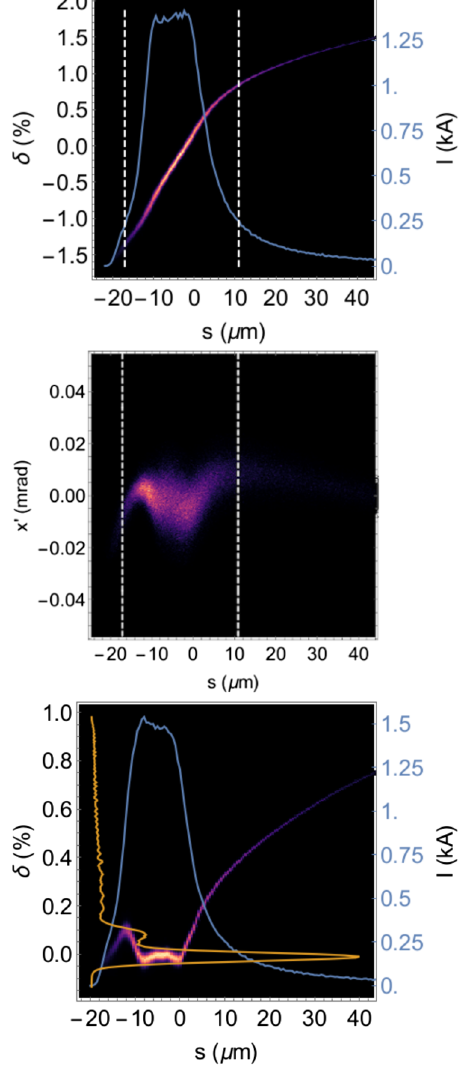
FIG. 5. Top: the longitudinal phase space at the exit of BC2, with current profile (blue), the white dashed lines define the core of the beam. Middle: s vs x 0 at the exit of BC2. Bottom: longitudinal phase space at the undulator entrance with current profile (blue) and energy lineout (yellow). The bunch head is on the left in all